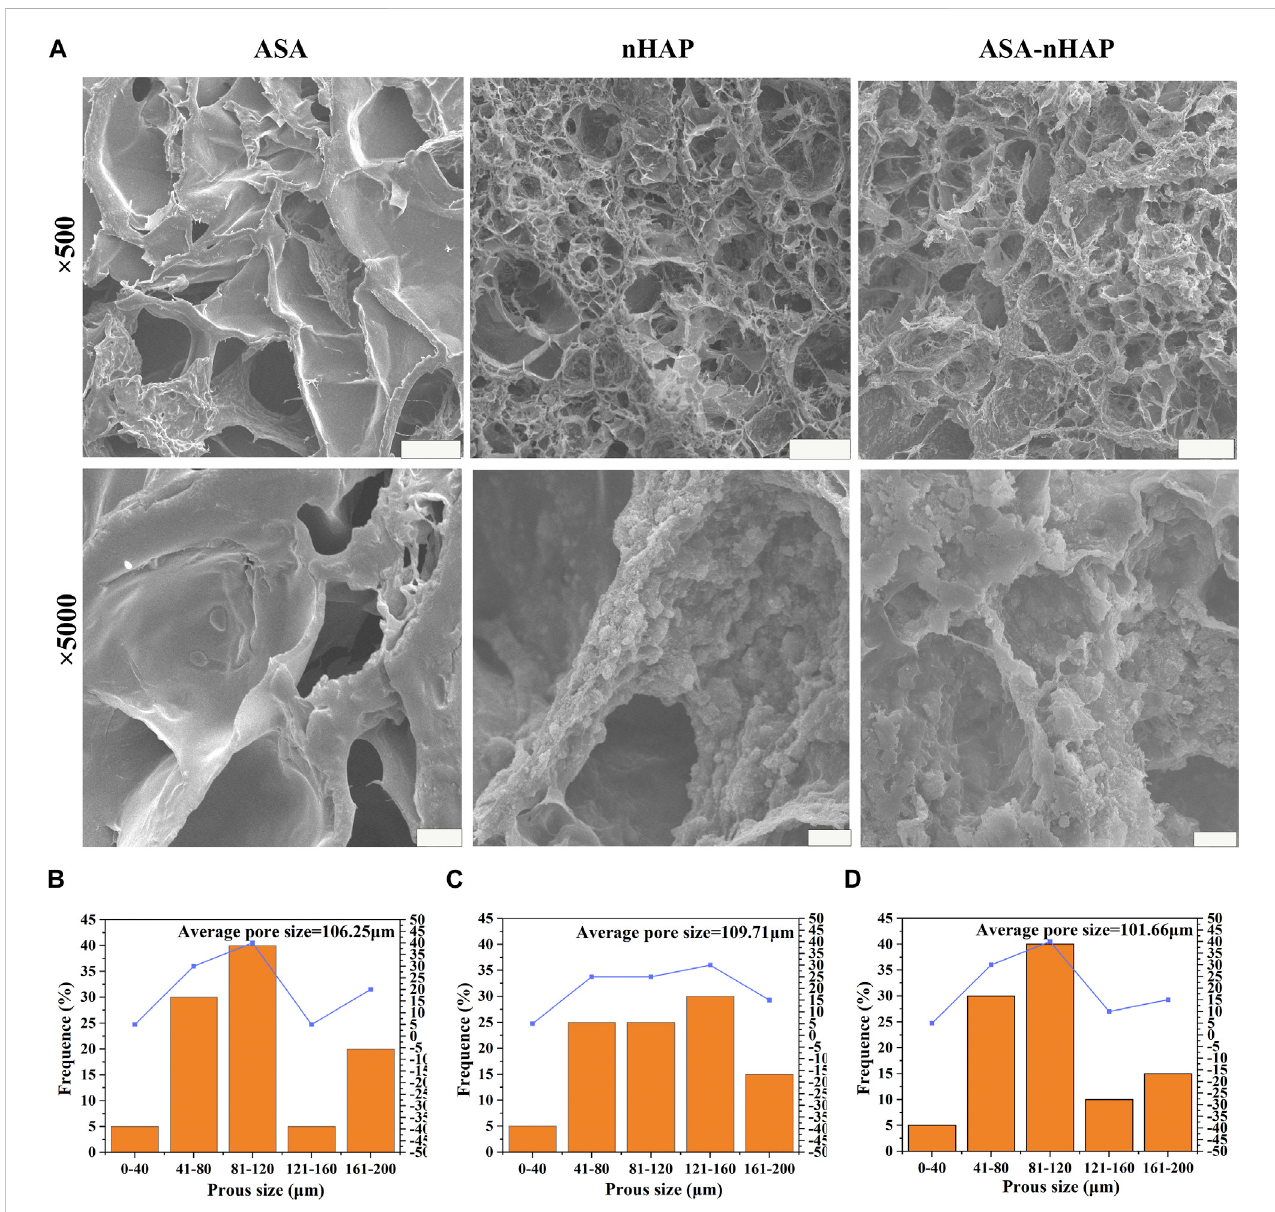
FIGURE 2 Microstructureofhydrogelscaffolds. (A) SEMimagesoftheASAgroup,nHAPgroup,andASA-nHAPgroup.Thescalebarforlow-magni fi cationimagesis 100 μ m; the scale bar for high-magni fi cation images is 10 μ m. (B – D) Pore size distribution pattern of the ASA group, nHAP group, and ASA-nHAP